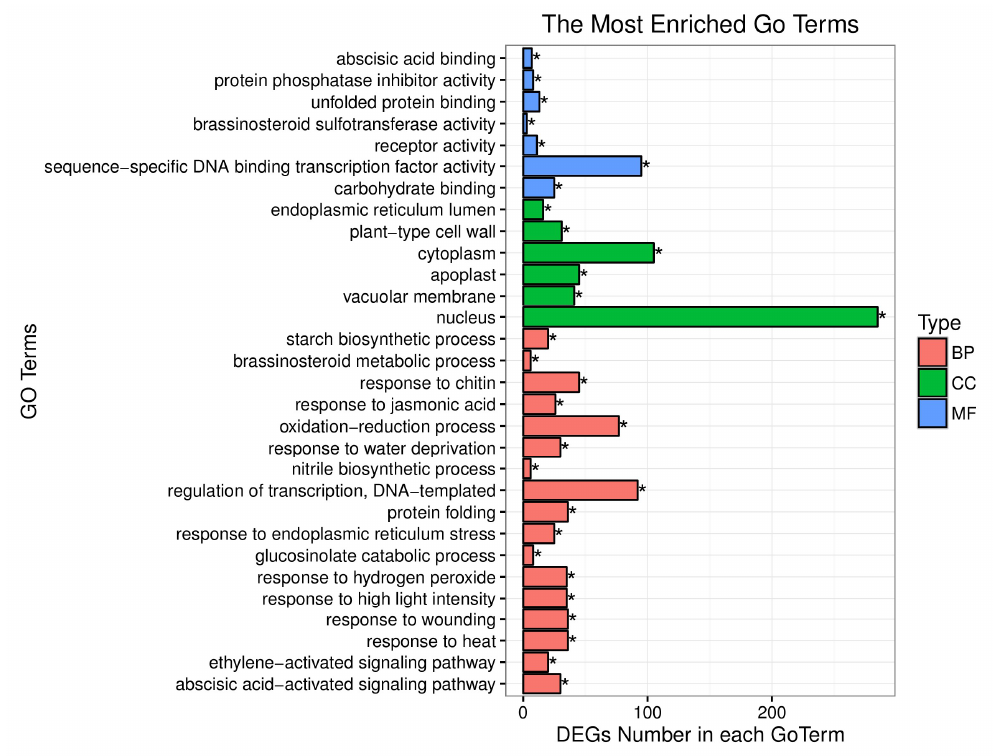
Figure 3. The thirty top GO assignments of 1112 DEGs. Blue: molecular function, green: cellular component, and red: biological process. The Y-axis represents the GO Term; the X-axis represents the number of DEGs for each GO Term. “*” indicates significant enrichment of the GO Term.